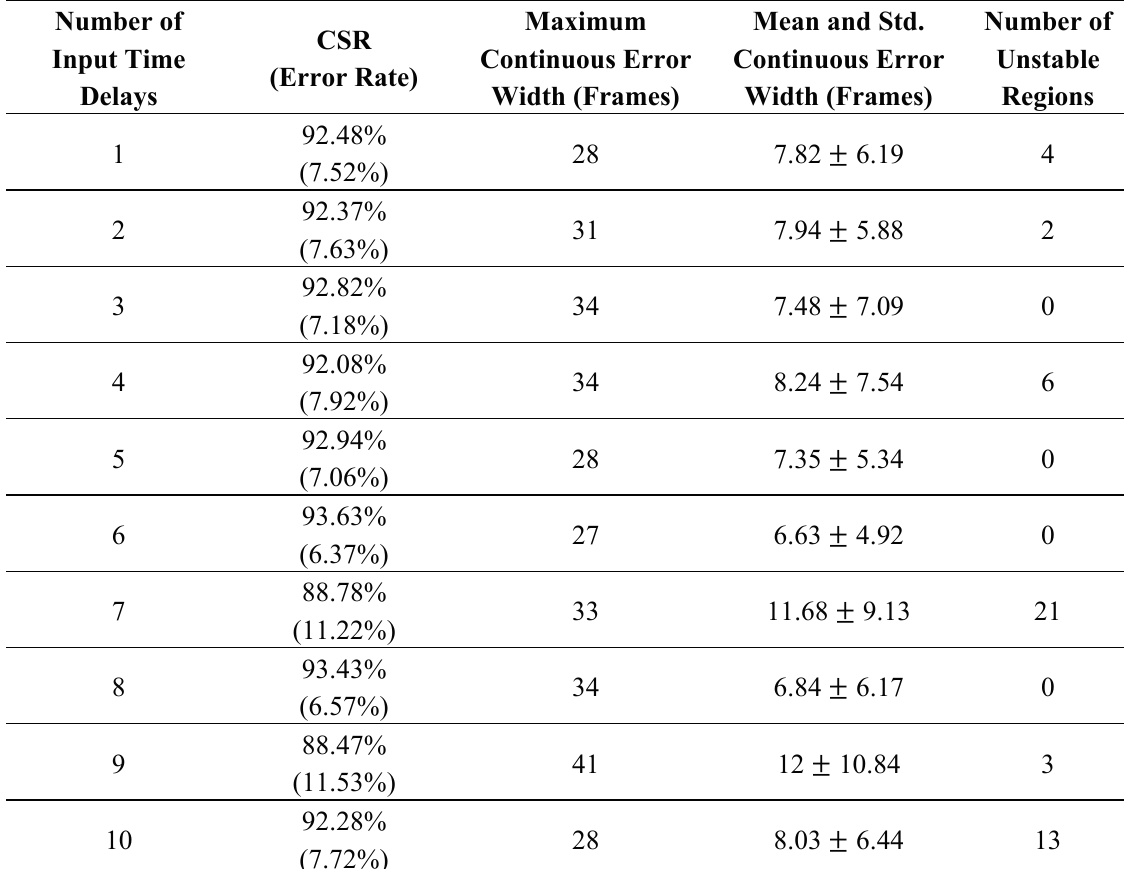
Table 5. Online classification results of walking phase classifiers with NARX